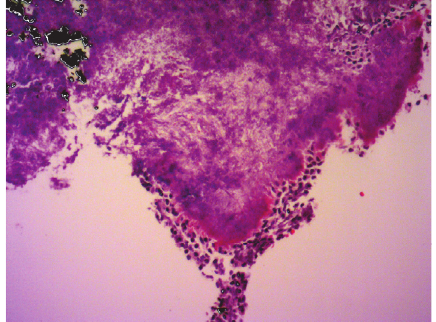
Figure 3: Sulfur granules from IUD,